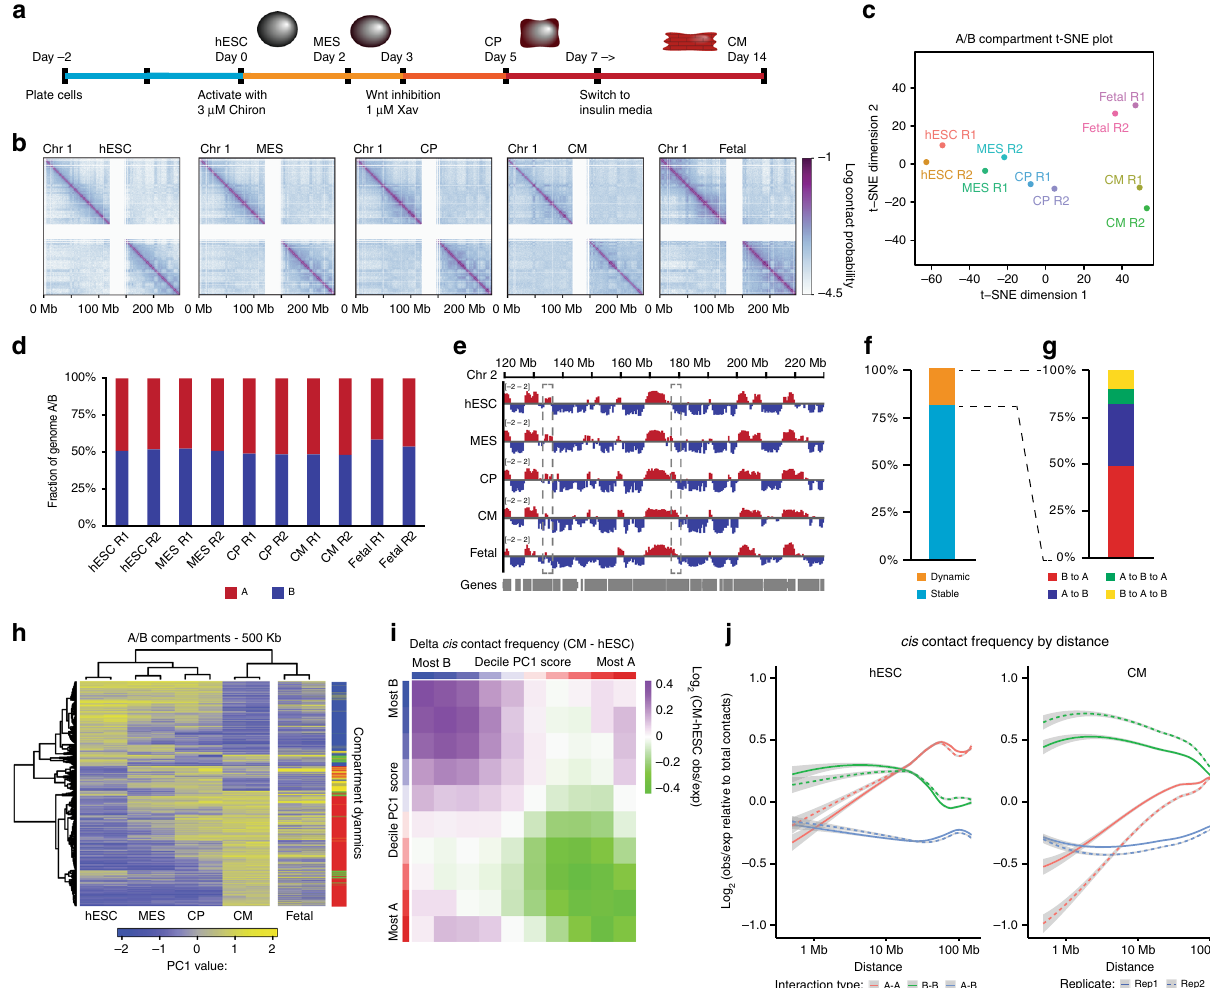
Fig. 1 Hi-C across cardiac differentiation. a Schematic of the cardiomyocyte differentiation. b Log transformed contact maps of chromosome 1. c t-SNE plot of PC1 scores on the contact matrices. d Fraction of genome in A and B compartment by sample. e PC1 scores for a region of chromosome 2, gray boxes highlight regions transitioning from A to B and B to A. f Genomic regions divided by stable (81%) and switching (19%) A/B compartment (PC1 scores signi fi cantly different by one-way ANOVA, p -value < 0.05; n = 2 independent differentiations). g Regions switching A/B compartment divided by types of transitions. A – B (33%), B – A (49%), A – B – A (8%), B – A – B (10%). Two percent of switching regions were A – B – A – B or B – A – B – A and were combined with A – B and B – A. h Heatmap of the PC1 scores of the compartment switching regions. Clustering of rows based on the four time points of differentiation. Dendrogram of columns was ordered to match the temporal status of differentiation. i Delta compartmentalization saddle plot in cis contacts CM vs. hESC. Bins were assigned to ten deciles based on PC1 score, average observed/expected distance-normalized scores for each pair of deciles were calculated. j Distance plot of A – A, B – B, and A – B interactions for hESC and CM, values are normalized to all contacts at a given distance. Data was smoothed using R, raw maps in Supplementary Fig. 3g. Source data are provided as a Source Data fi